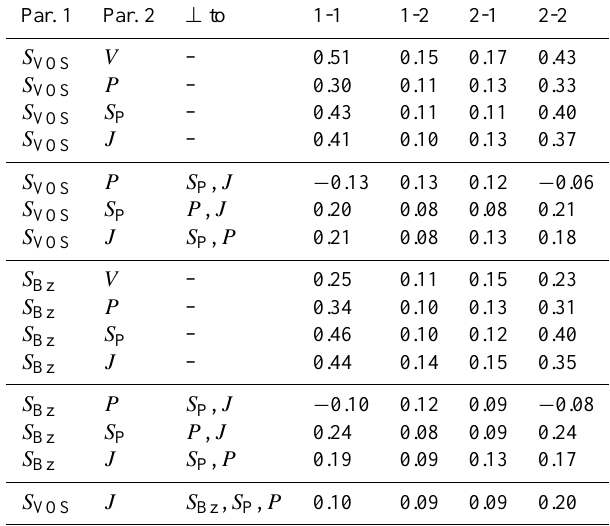
Table 2. Average correlation coefficients for different parameter pairs inside one-year intervals (columns 1-1 and 2-2) and between years (columns 1-2 and